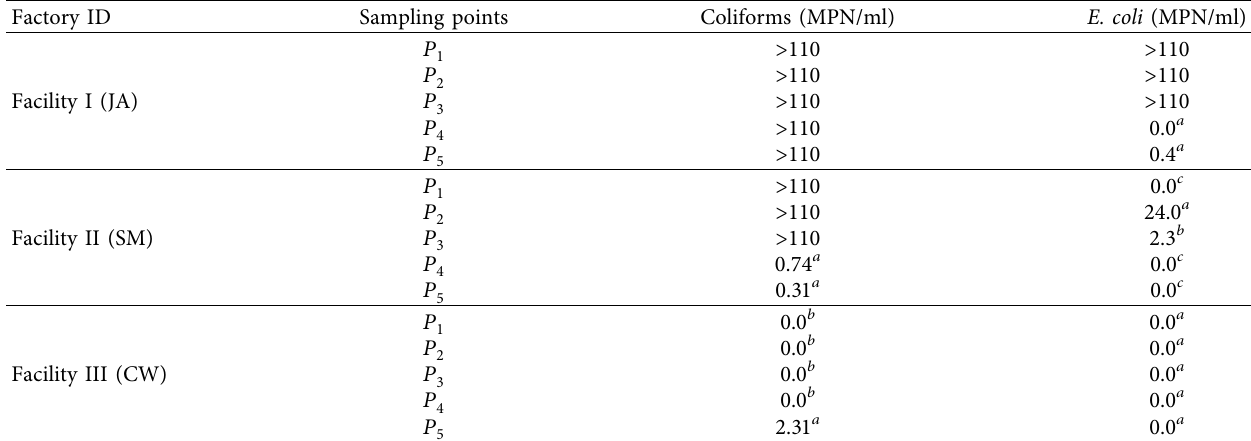
Table 4: Coliforms and E. coli counts at different sampling points in three factory premises. Factory